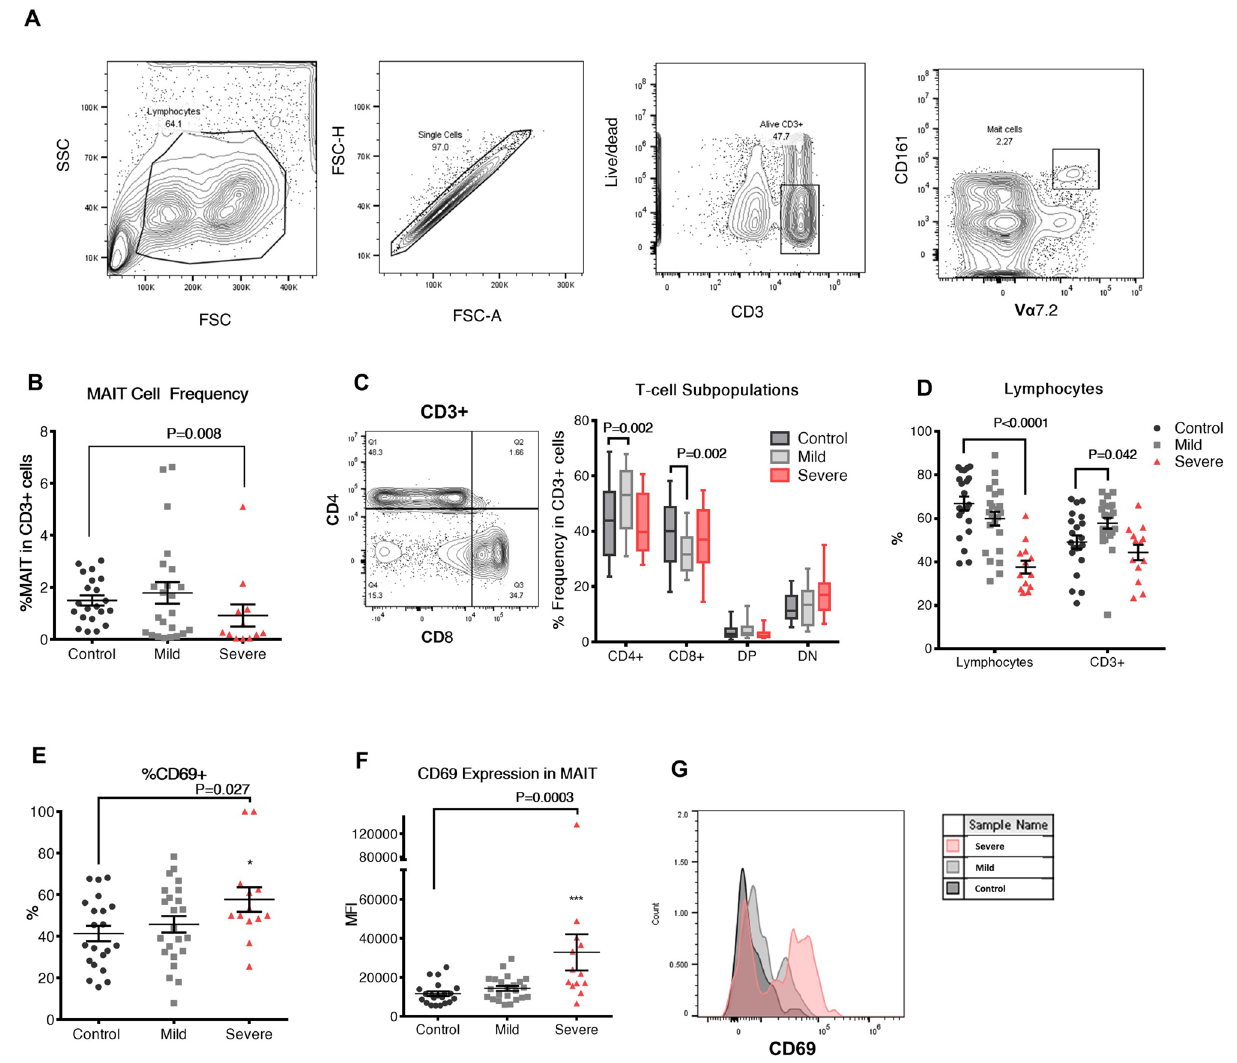
Figure 1. Prevalence of MAIT cells and other CD3+ populations in COVID-19 patients compared to uninfected individuals. ( A ) Gating strategy for identifying CD161 + Vα7.2 + MAIT cells in PBMCs done on a healthy control. ( B ) MAIT cell frequency in CD3+ population of PBMCs isolated from the mild and severe groups as compared to the control group. ( C ) Percentage of CD4 and CD8 double positive (DP) and double negative (DN) T-cell subpopulations in CD3+ cells of COVID-19 patients compared to unaffected individuals. ( D ) Percentage of the lymphocyte population identified in PBMCs isolated from peripheral blood of uninfected control individuals compared to COVID-19 mildly affected and severely affected patients and the prevalence of CD3+ cells in the lymphocyte population. ( E ) Percentage of MAIT cells expressing CD69 and ( F) Mean fluorescence intensity (MFI) of CD69 in MAIT cells of healthy controls and COVID-19 patients reflecting the activation state of these cells. The Mann–Whitney test was conducted to compare each patient group with the control group in ( B , D , F ), error bars indicate the standard error of the mean. For ( C , E ), multiple t-tests with Holm-Sidak’s correction for multiple comparisons were conducted. ( G ) Histogram representation of CD69 expression in one healthy control, one mildly affected and one severely affected COVID-19